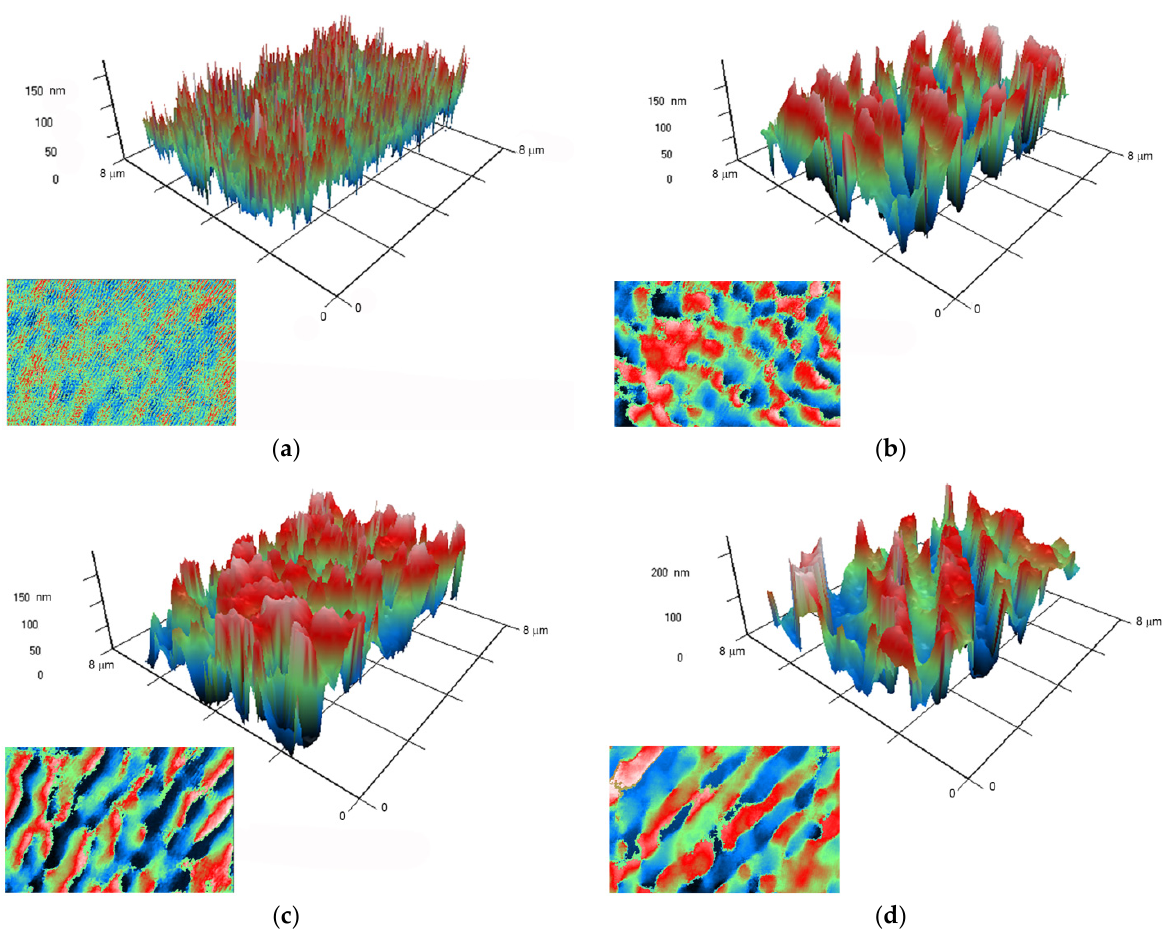
Figure 6. Images obtained on polymer without nanoparticles ( a ), and polymers with Ag 2 O nanoparticles at concentrations of 0.001% ( b ), 0.01% ( c ), and 0.1% ( d ), using a ja. A 3D reconstruction of the surface profile of a polymer and composites based on it is presented. The X and Y axes show the actual size of the investigated surface in micrometers. The Z-axis shows the surface relief as a phase change expressed in nm. The surface elevation map is in left lower part in each picture.